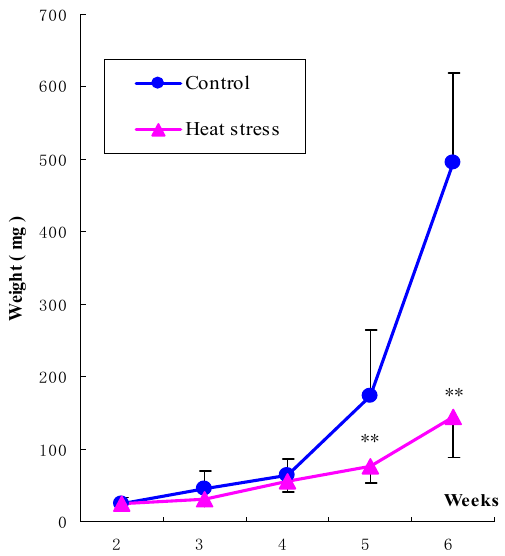
Figure 3. Effects of HS on the weight of testis in Wenchang chicks ( n = 6). Note: compared between CK and HS groups at the same age. ∗∗ P < 0 .